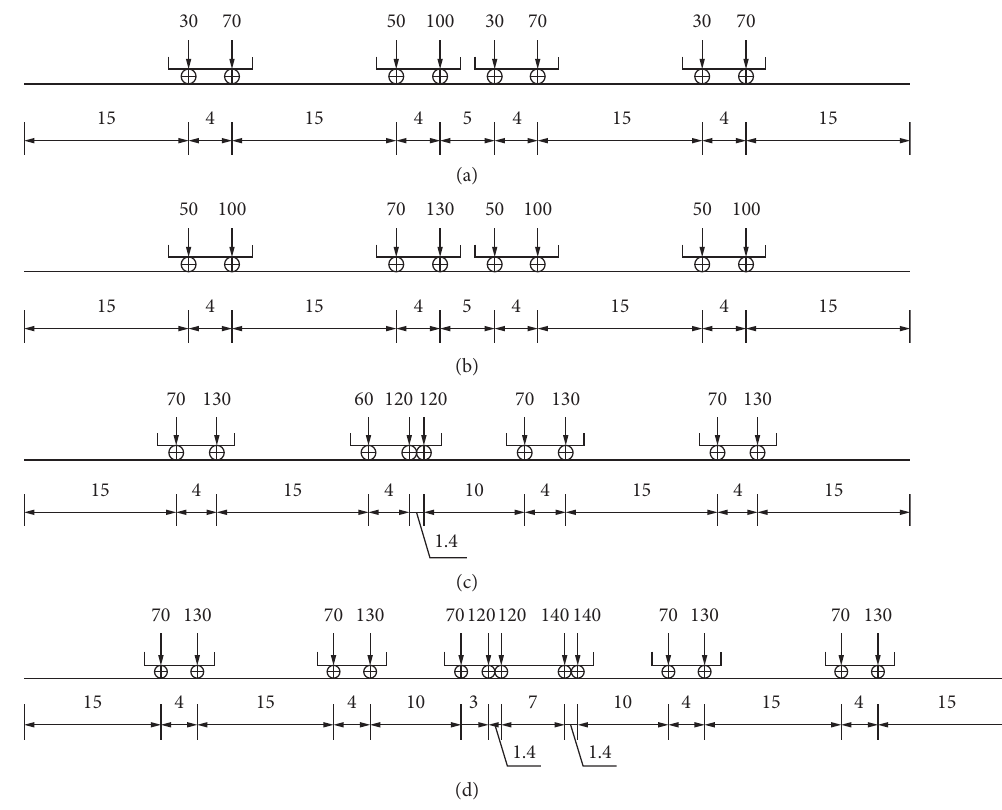
Figure 1: Different traffic load grades in JTJ 021-89: (a) traffic-10; (b) traffic-15; (c) traffic-20; (d) traffic-over 20. P k q k Figure 2: Different traffic load grades in JTG